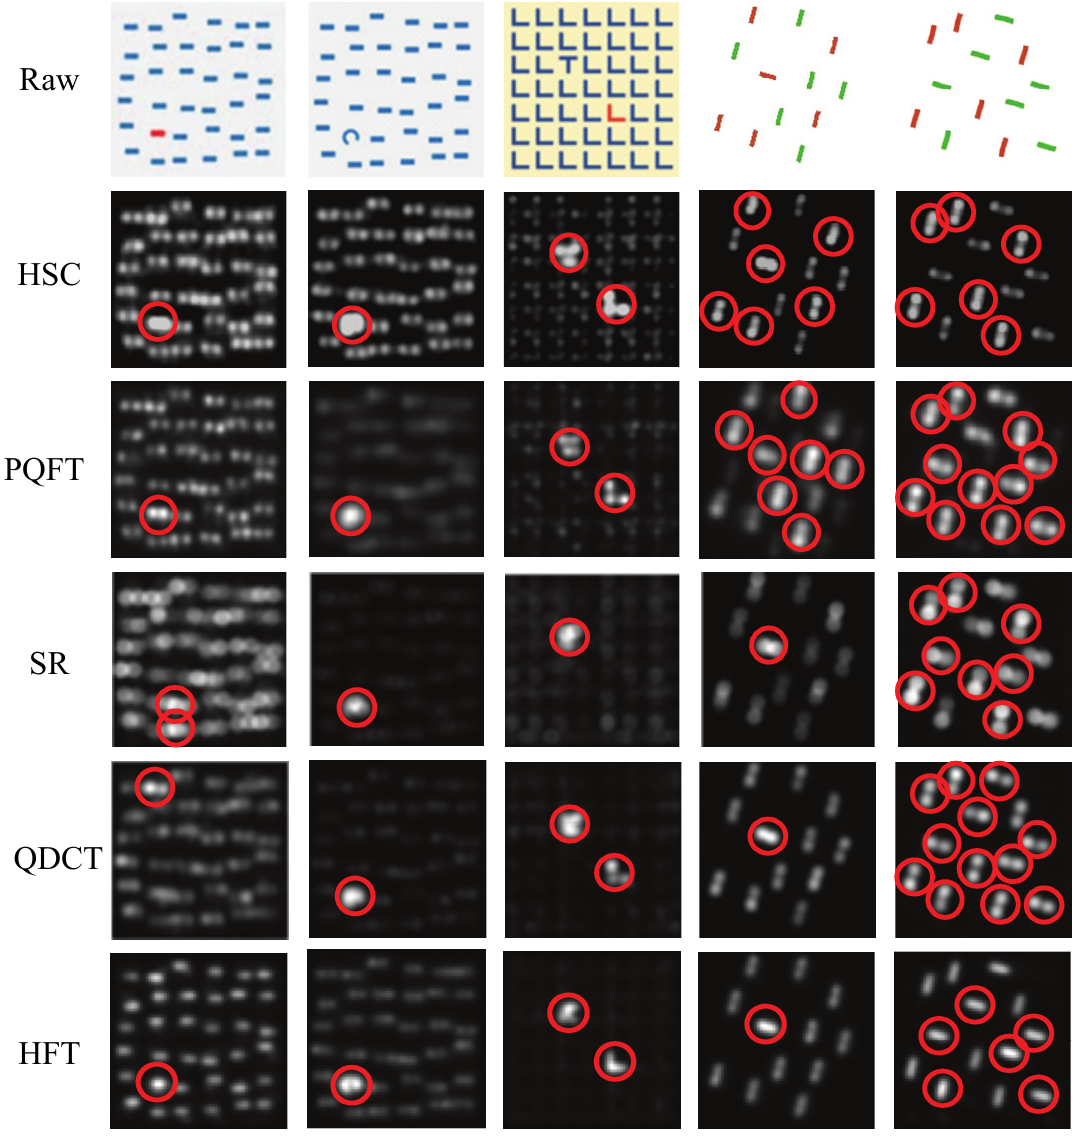
Figure 4. Comparison of our method with [26,27,34,39] on psychological patterns. The first row is the raw images; the second to sixth row are results produced by our method (HSC) and [26,27,34,39],